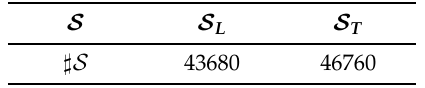
Table 1. Number of fingerprints in each series for MIS